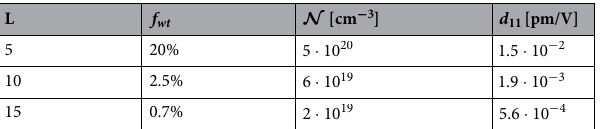
Table 1. NLO susceptibility tensor ˜ d values of relative distance L , weight fraction f wt and concentration N . The non-zero coefficients of d il are d 11 d 21 d 26 = − = −